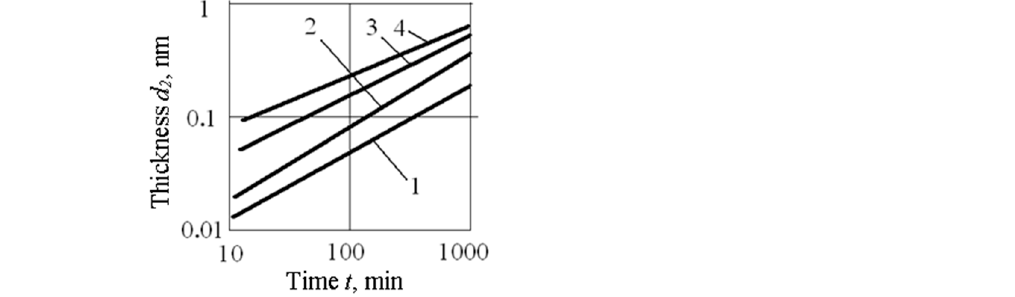
Figure 4. Dependence of the SiO 2 film thickness d 2 on the oxidation time t in dry oxygen at temperatures: 1 → 900 °C; 2 → 1000 °C; 3 → 1100 °C; 4 → 1200 °C. The error δ d 2 is ( δ v 2 + 100% × Δ t / t ) or δ d 2 is ( δ v 2 + 50% × Δ t /( t ) 1/2 ), where δ v 2 depends